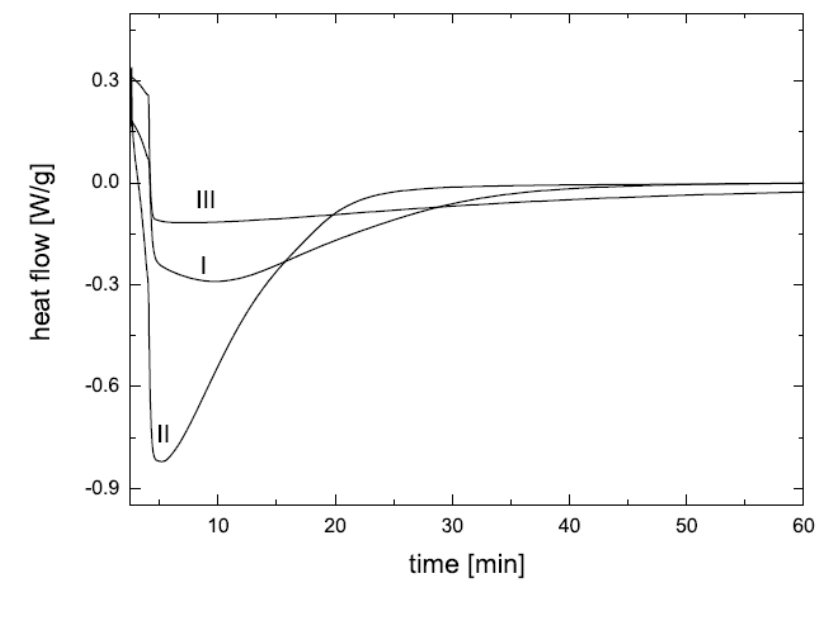
Figure 14. DSC thermograms indicating the effect of filler on curing at 70 °C; I: no filler, amine to epoxy mole ratio 0.3:1, II: 3.5 vol% 2C18-OMMT, amine to epoxy mole ratio 0.3:1 and III: 3.5 vol% 2C18-OMMT, amine to epoxy mole ratio 0.2:1